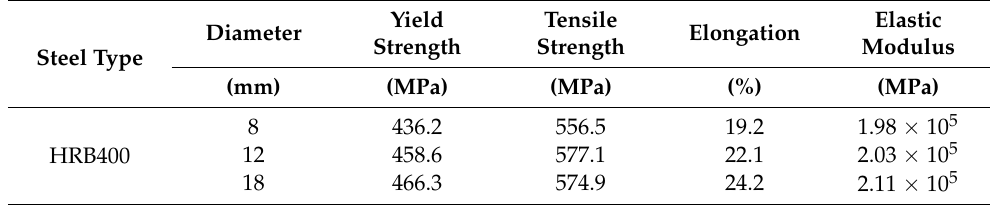
Table 2. Mechanical properties of